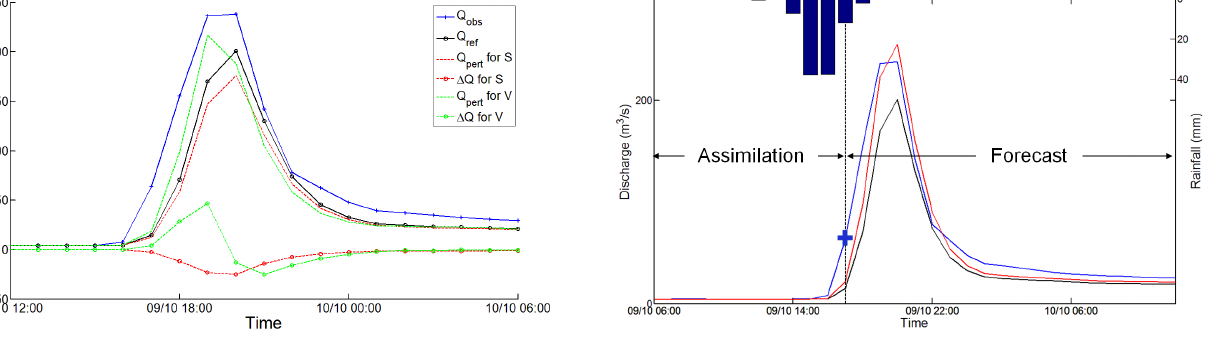
Fig. 1. Sensitivity tests conducted on parameters V and S for the October 2001 event. Q obs (blue line) is the observed hydrograph, Q ref (black line with circles) is the “free run”, Q pert is the “perturbed” simulation done with a +10% perturbation of S (dashed red line) or V (dashed green line); 1Q is the difference between the “perturbed” simulation and the “free run” for S (in dashed red line with circles) or V (dashed green line with circles).